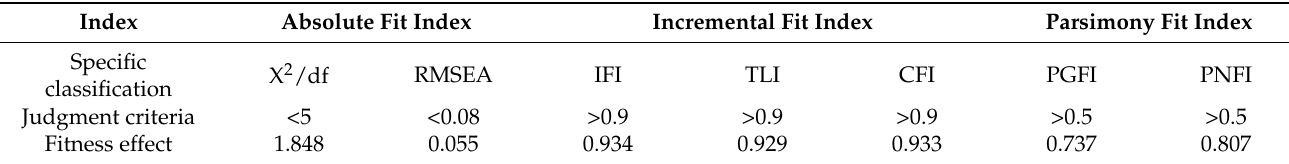
Figure 2. Mediation model. Table 5. Mediation model fitting index.